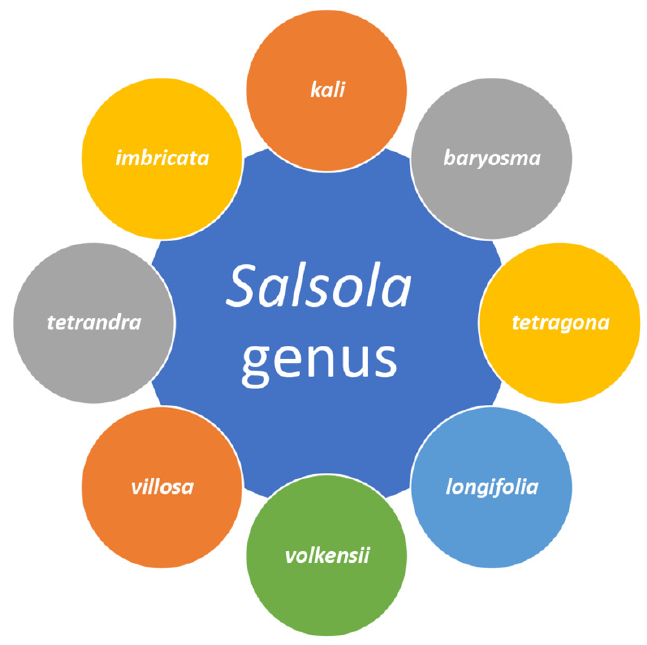
Figure 1. Representative example of the most-studied species of the genus Salsola.